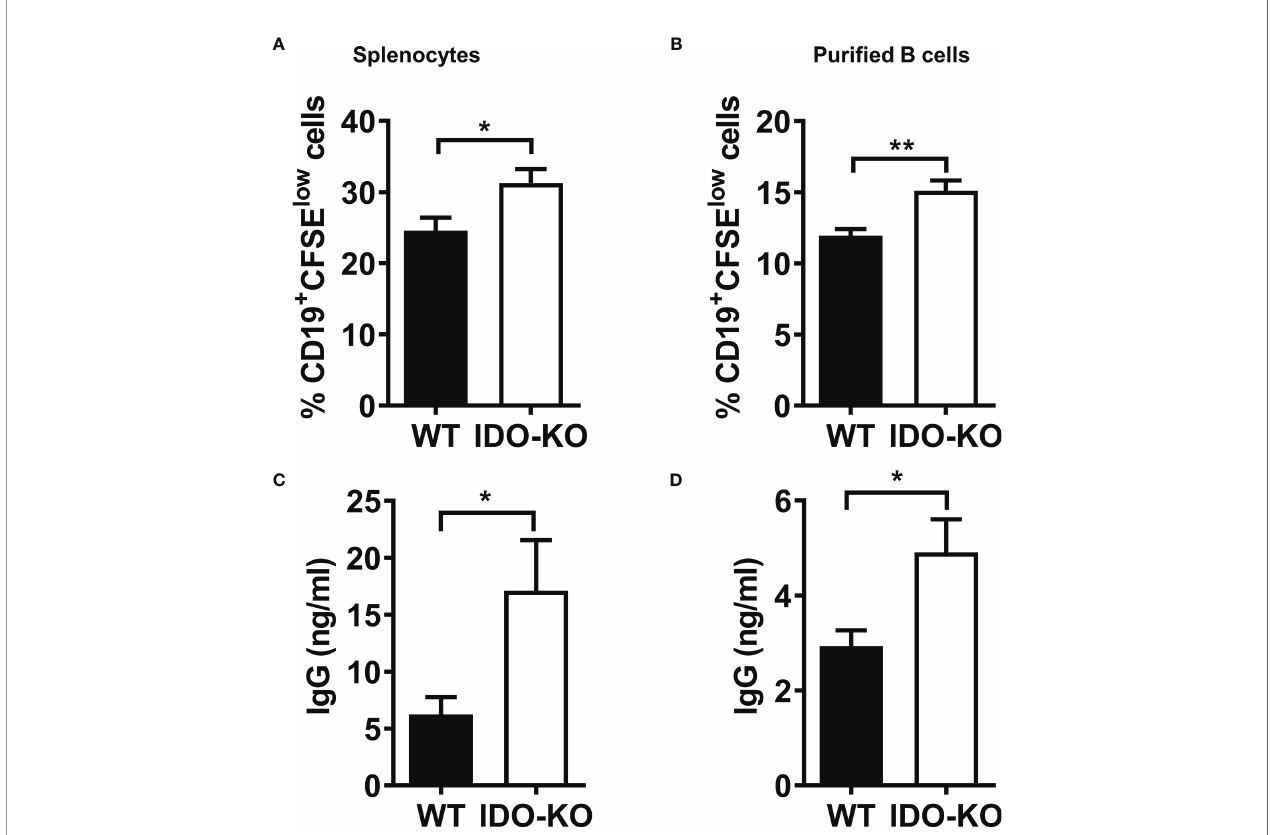
FIGURE 7 | IDO negatively regulate B cell proliferation an IgG production. (A, B) Splenocytes (A) or CD19 + B220 + B cells sorted (B) from tumor-bearing mice on day 9 post-LLC i.c. challenge were labeled with CFSE and cultured with LPS (20 µg/ml) and IL-4 (10 ng/ml). The percentages of CD19 + CFSE low cells were determined by FACS analysis on day 4 of culture. (C, D) culture (C) or puri fi ed B cells (D) on day 4 of culture. The levels of IgG in the culture supernatants were determined by ELISA. * P < 0.05, ** P <